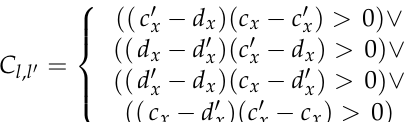
Figure 2. Overlap constraint. ( a ) Reference image; ( b ) search image. L is the reference line on the reference image and the blue lines on both images are the corresponding epipolar lines for the end- points of the L . The red feature lines on the search image are a set of candidates that satisfy the overlap constraint.